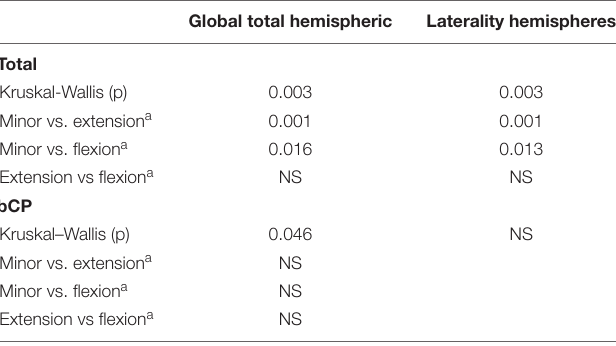
TABLE 5 | Statistically significant differences in sqMRI extent scores among the multiple joint